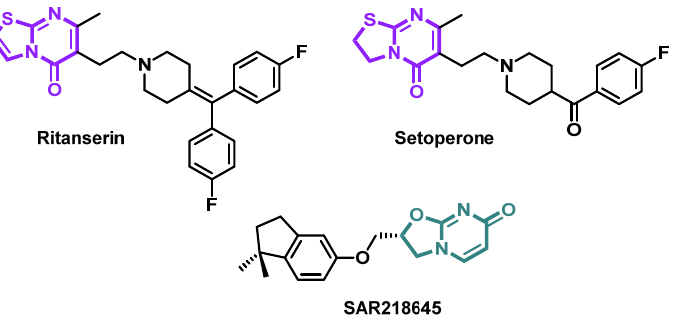
Figure 1. Examples of thiazolo- and oxazolo[3,2- a ]pyrimidinone structural analogues used in clinical medicine.